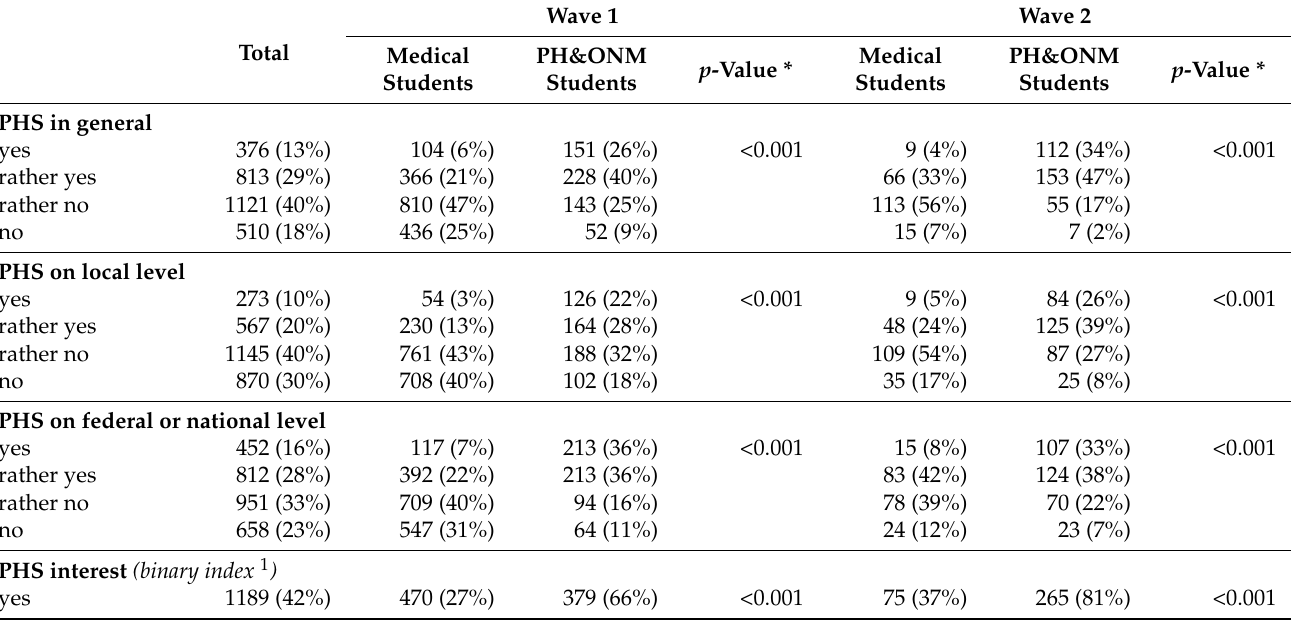
Table 2. General interest in working in the Public Health Service (PHS) among students in Germany by territorial authority and separated for wave 1 ( n = 2450) and 2 ( n = 569),